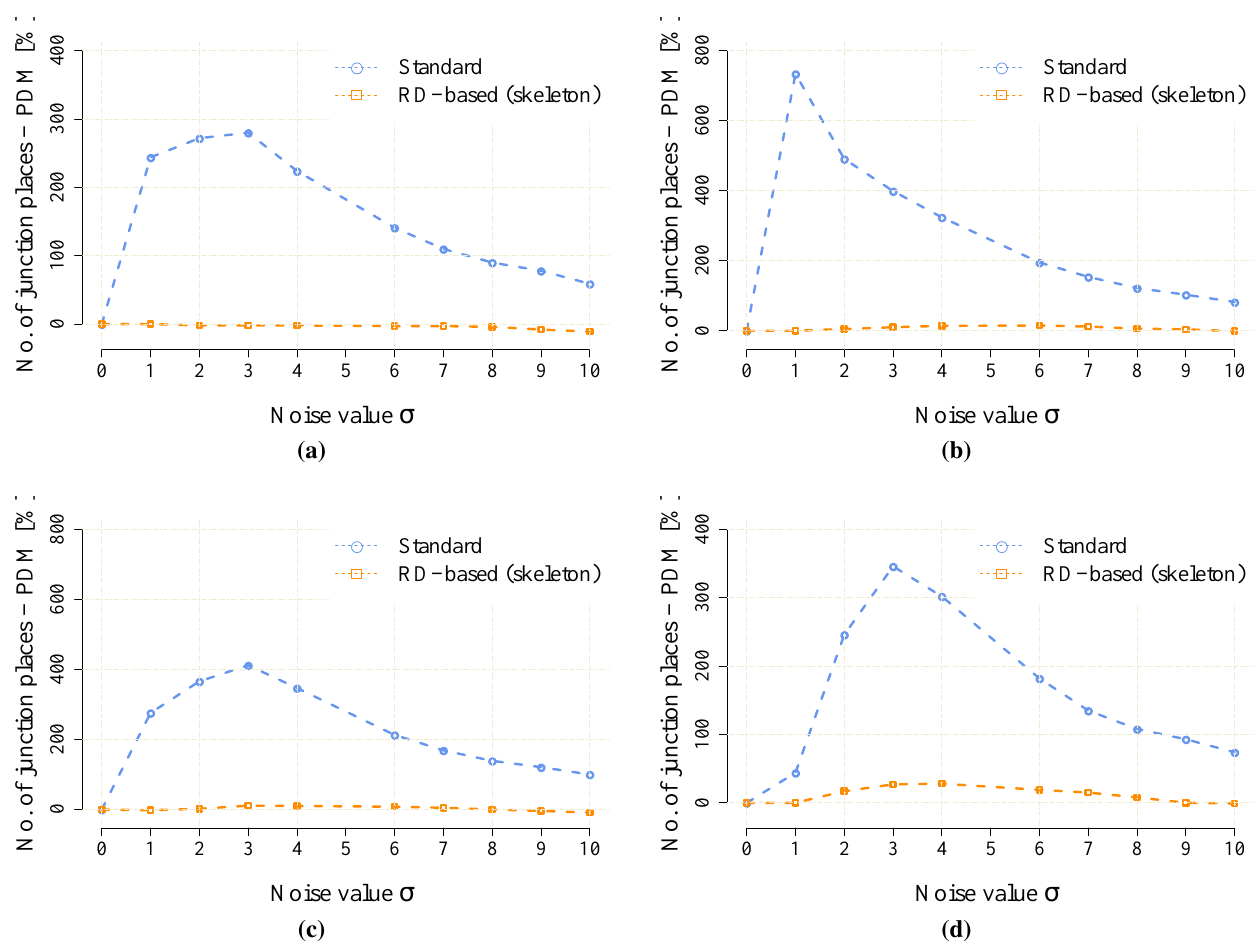
Figure 17. The noise sensitivity indicator JPDM Equation (3) in the scaled noisy maps of the potholes environment. ( a ) potholes , 960 × 960; ( b ) potholes , 1200 × 1200; ( c ) potholes , 1360 × 1360; ( d ) potholes , 1600 ×